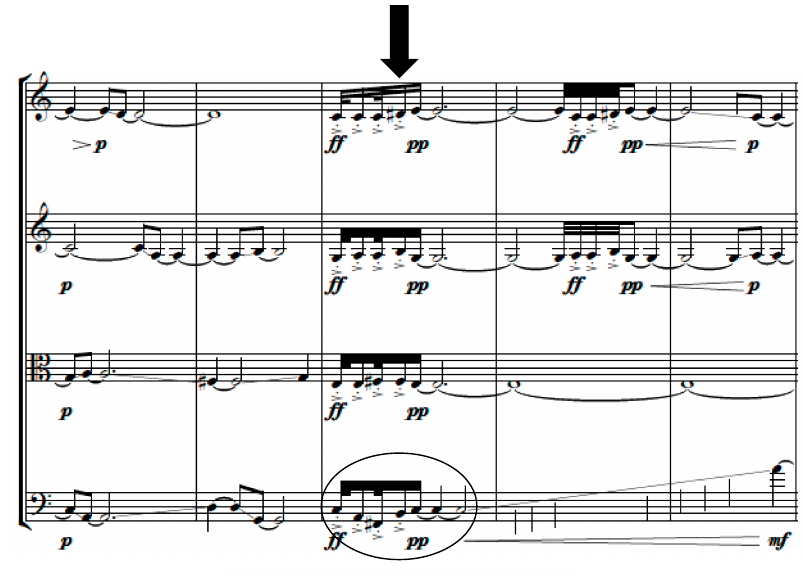
Figure 11. Macklay, Many Many Cadences , measure 108 (B section). Figure 11. Macklay (2014) Many Many Cadences , measure 108 (B